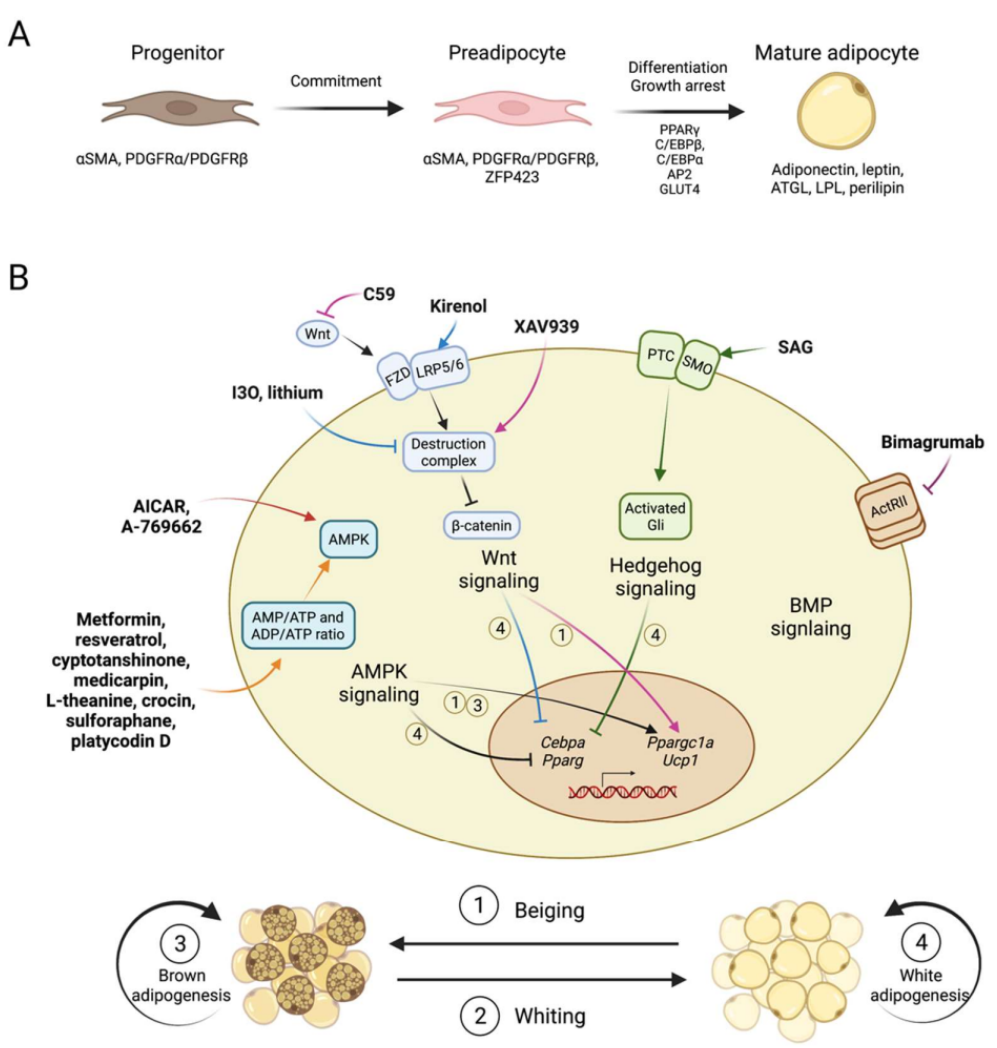
Figure 1. Compounds regulating adipogenesis through various signaling pathways. ( A ). Overview of the process of adipogenesis. Progenitor marked by α SMA, PDGFR α /PDGFR β will firstly make a commitment to preadipocyte, and then differentiate into mature adipocyte. During the differentiation process, some transcription factors that are critical to adipogenesis, like PPAR γ , C/EBP β , C/EBP α et al., are required. ( B ). Compounds regulating adipogenesis through various signaling pathway. Adipogenesis-regulating compounds are shown in bold, and their pathway-modulating mechanisms are presented briefly. For regulated adipogenesis, the four processes including beiging, whiting, brown adipogenesis and white adipogenesis are of concern. Beiging stands for elevated thermogenic ability and increased brown adipocyte characteristics in white adipocyte or white adipose tissue. Whiting stands for the loss of thermogenic ability and brown adipocyte characteristics of brown adipocyte or brown adipose tissue. Brown adipogenesis stands for increased brown adipocyte differ- entiation or thermogenic ability in brown adipocytes or brown adipose tissue. White adipogenesis stands for increased white adipocyte differentiation in white adipocytes or white adipose tissue. In general, the activation of the AMPK signaling pathway through certain compounds is shown to inhibit white adipogenesis, and promote beiging of white adipogenesis and brown adipogenesis. Ac- tivation of the canonical Wnt signaling pathway through certain compounds is shown to inhibit white adipogenesis, and its inhibition is shown to promote beiging of WAT. Activation of the Hedgehog signaling pathway is shown to inhibit white